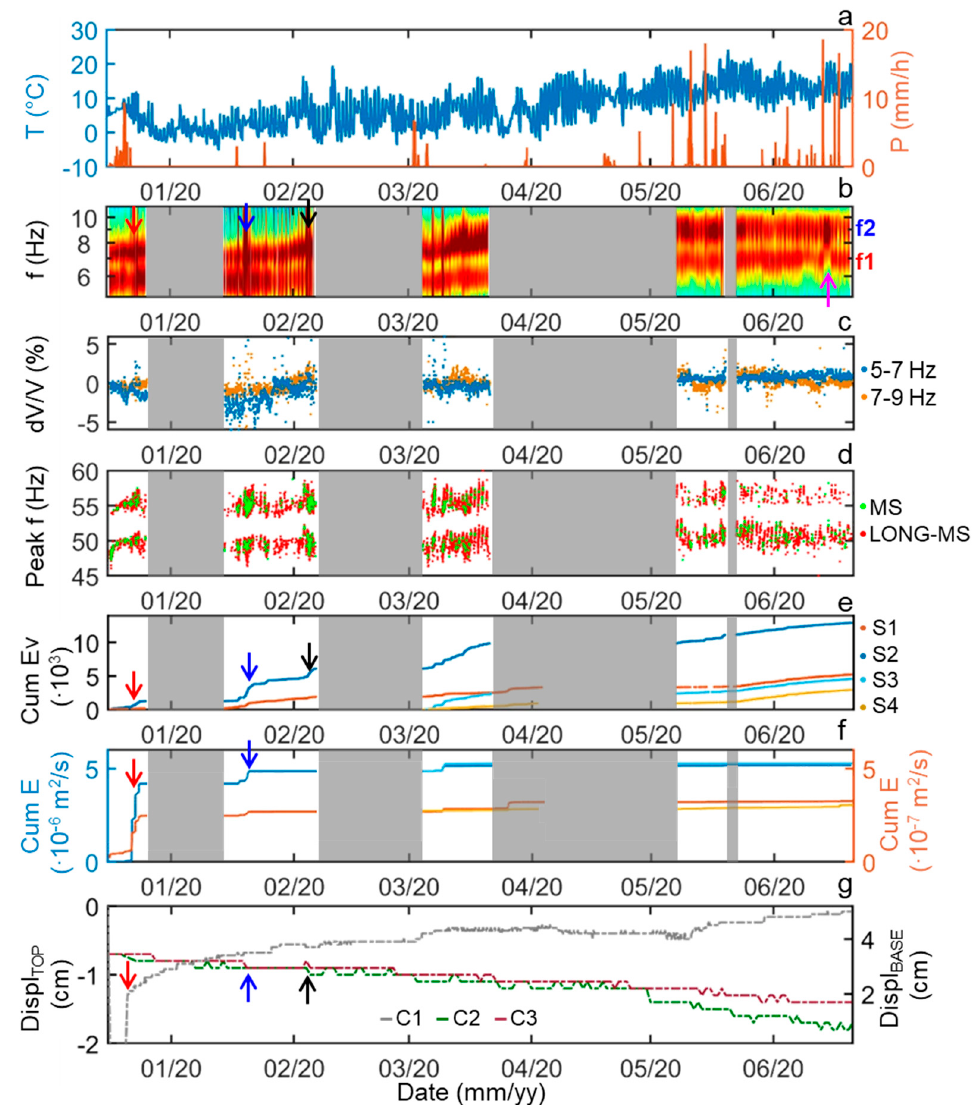
Figure 11. Comparison of ambient noise and microseismicity results with meteorological variations and displacement measurements. ( a ) air temperature variations (blue) and hourly precipitation amount (orange) at the nearest ARPA Piemonte meteorological station (Ormea–Ponte di Nava). ( b ) Zoom on H2/V2 spectral ratio around the first two resonance frequencies (same color scale of Figure 5c). ( c ) Seismic velocity changes retrieved from ambient noise cross-correlation in the frequency bands overlapping f1 and f2. ( d ) Peak frequency of the microseismic events recorded at S2. ( e ) Cumulative number of tower-related (MS, LONG-MS, LOW-F) events recorded at the four monitoring stations. ( f ) Related cumulated seismic energy. To improve the comparison, the cumulated energy of S3 and S4 (operating from March 2020) is plotted starting from the cumulated energy value of S2 and S1 respectively at their first day of recording. ( g ) Displacement measurements at C1 (tower base), C2 and C3 (tower top). No data periods for S2 are shaded in gray. Colored arrows mark salient windows in which the seismic response is not correlated to air temperature modifications: spectral content perturbations and high microseismicity after precipitations or concomitant to displacement (e.g. in red, blue, black), f1 spectral amplitude decrease after intense precipitation (in magenta).